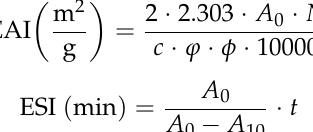
Figure 1. The appearance of the prepared aquafaba-based mayonnaise samples with blends of refined rapeseed oil and cold-pressed rapeseed oil (MRO), cold-pressed sunflower oil (MSO), cold-pressed linseed oil (MLO), and cold-pressed camelina oil (MCO).